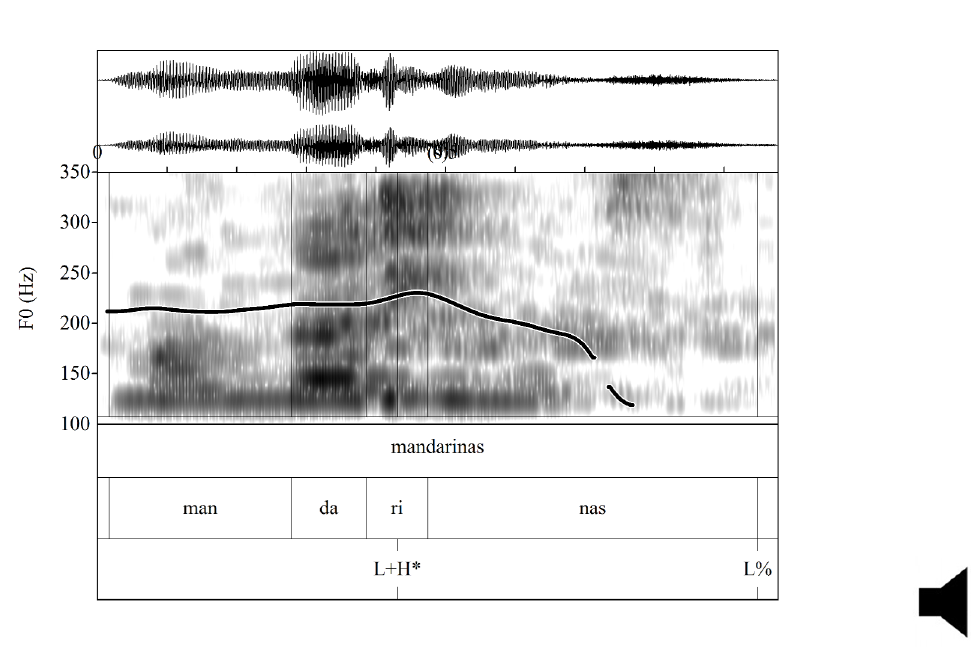
Figure 3 (Participant 3): Waveform and F0 trace for the broad focus statement Mandarinas ‘Tangerines’ with a nuclear pitch accent produced with L+H* followed by an L% boundary